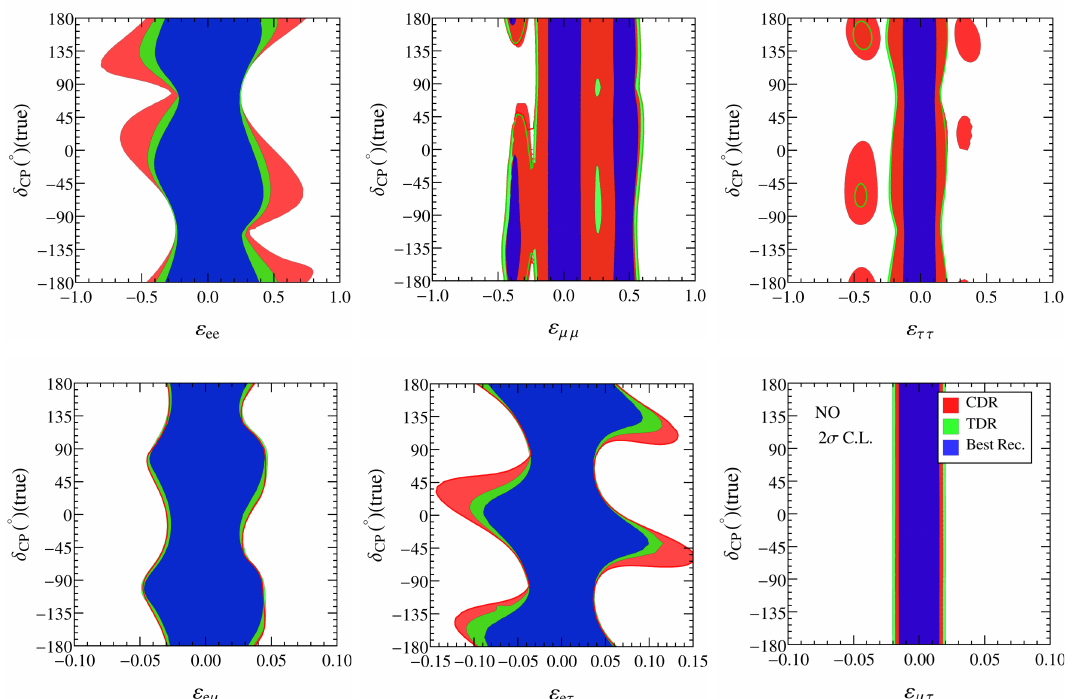
Figure 5 . Projected allowed regions in the plane spanned by the δ CP (true) and the NSI parameters at 2 σ C.L. ( ∆ χ 2 = 4 ). The red contours represent the DUNE sensitivity for the CDR configuration, green contours correspond to the TDR setup, and the blue contours are for the Best Reconstruction case. Normal mass ordering is assumed to be fixed in the data as well as in theory. We have considered the NSI parameters to be real.